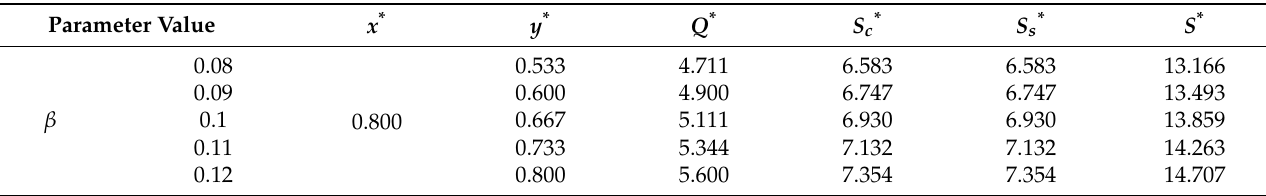
Table 4. Impact of QB coefficient β on equilibrium